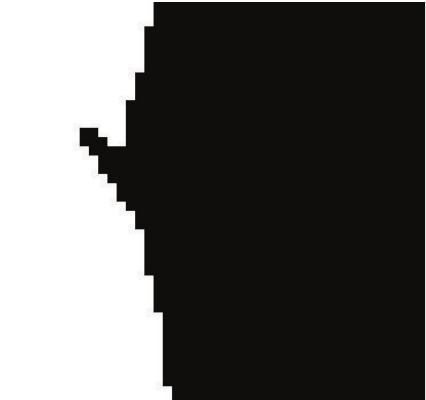
Figure 12: The protrusion at the boundary of one finger is erro- neously detected as another